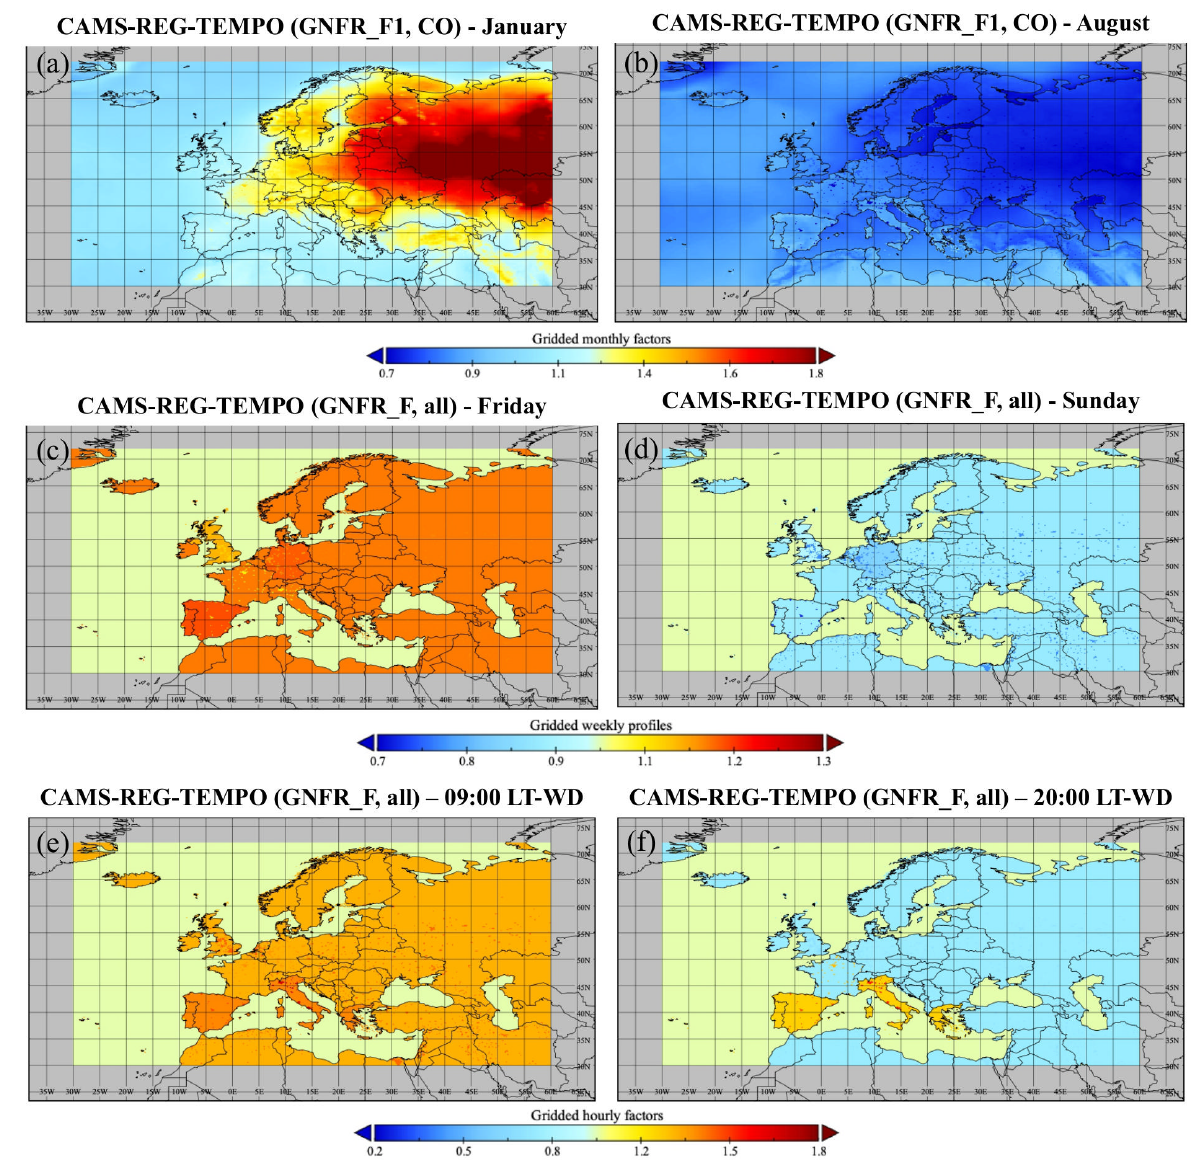
Figure 7. CAMS-REG-TEMPO (0.1 × 0.05 ◦ ) monthly- (a, b) , weekly- (c, d) and hourly-scale (e, f) factor maps. Monthly factors correspond to the meteorology-dependent profiles computed for CO exhaust gasoline emissions (GNFR_F1) for January and August (climatology of 2010–2017). Weekly factors are represented for Friday and Sunday. Hourly factors are represented for weekdays (WD) at 09:00 and 20:00 local time (LT). Administrative boundaries are derived from the Micro World Data Bank (MWDB2, 2011).